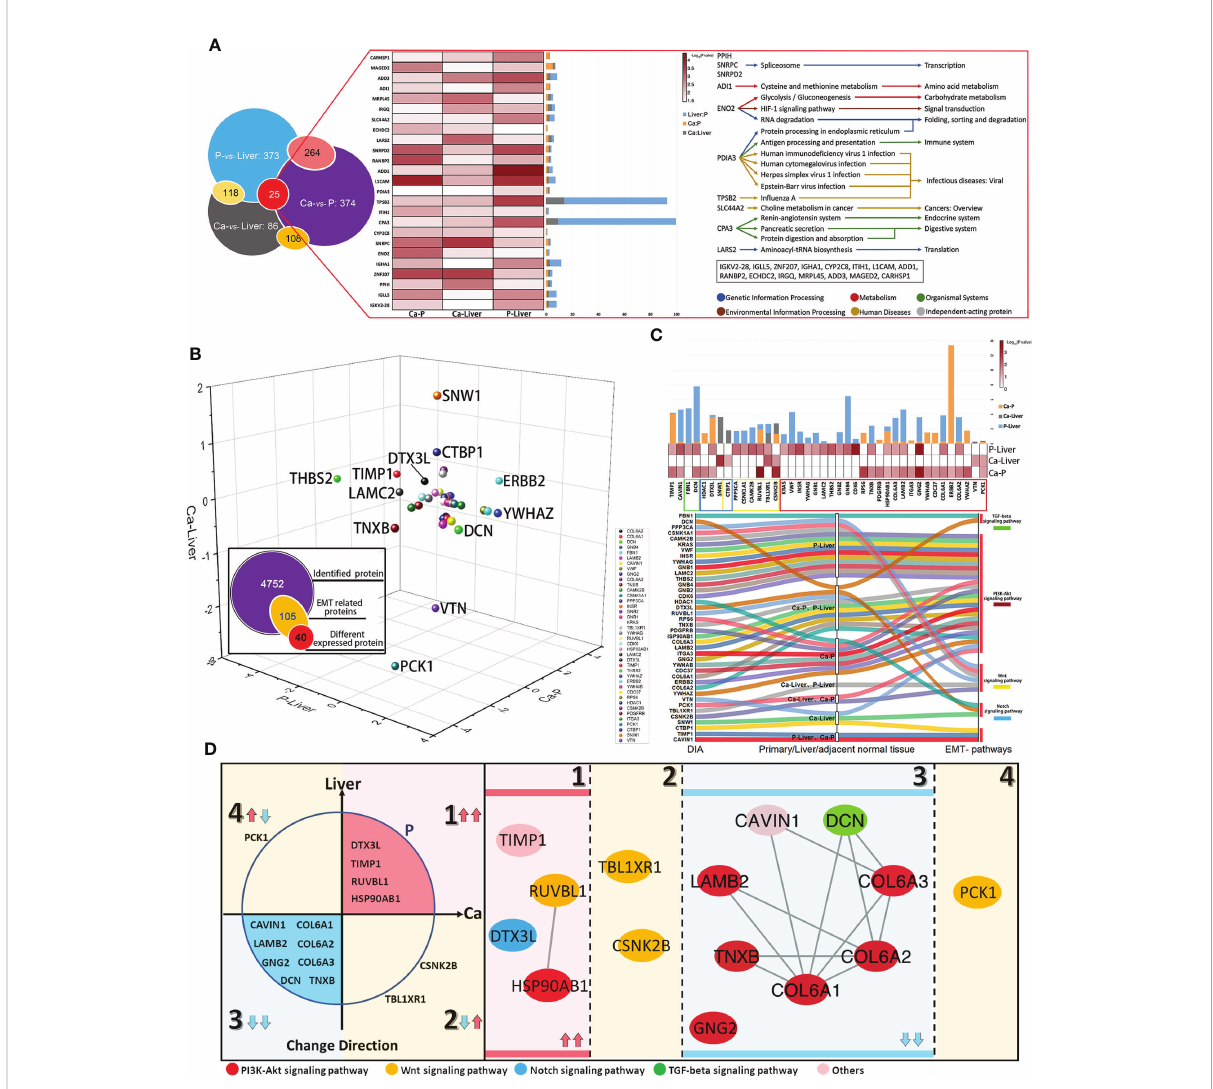
FIGURE 4 EMT-related metastasis core kinesin and structural helper proteins. (A) Relationship of differentially expressed proteins among Ca-Liver, Ca-P and P-Liver. Summary of 25 covariously expressed proteins in the three groups. (B) The change directions of 40 EMT-related differentially expressed proteins among Ca-Liver, Ca-P and P-Liver are shown in three-dimensional scatter plot. Log 2 (FC) of protein levels in P-Liver (x axis), Ca-P (y axis) and Ca-Liver (z axis) are shown. (C) Integrated analysis of 40 EMT-related proteins. (D) 40 EMT-related Proteins can be divided into four groups: (1) upregulated in both Ca-P and Liver-P; (2) upregulated in Ca-Liver; (3) downregulated in both Ca-P and Liver-P; (4) downregulated in